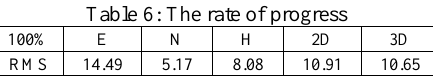
Table 6: The rate of